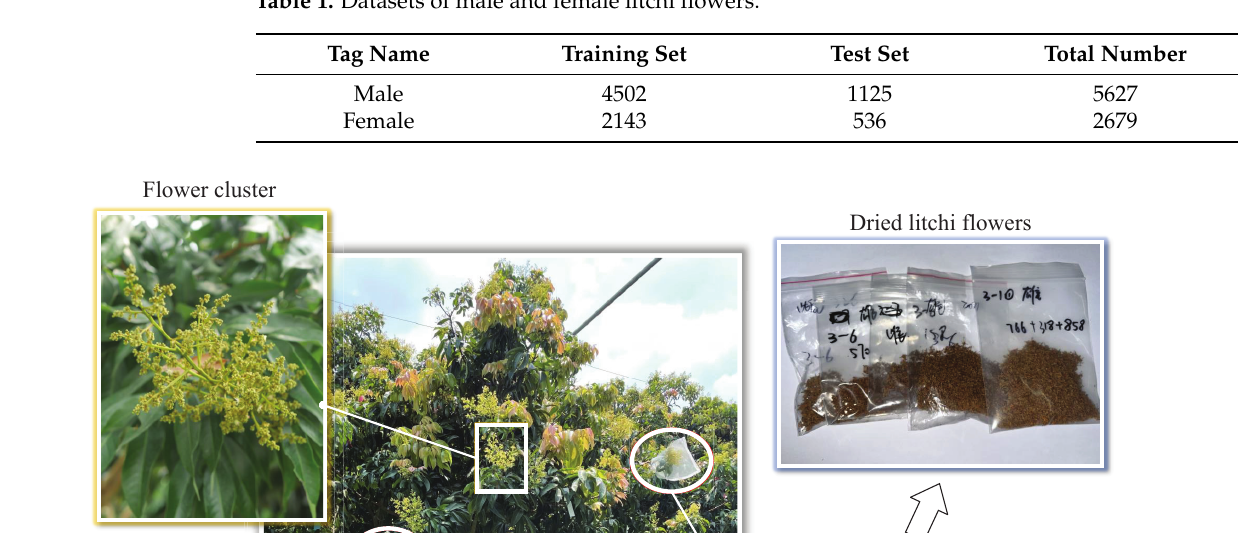
Table 1. Datasets of male and female litchi flowers.